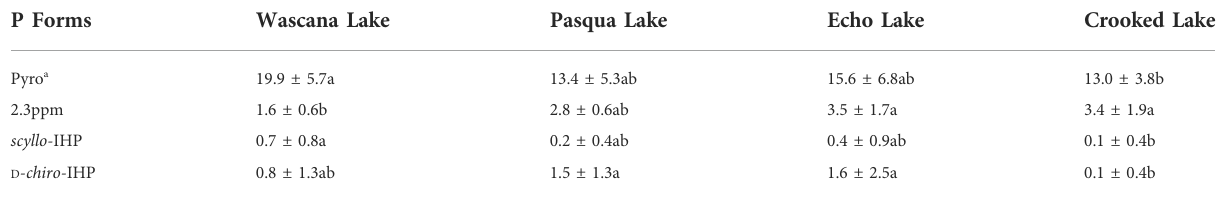
TABLE 3 Concentrations (mgP kg − 1 dryweight) of sediment P species inNaOH-EDTAextracts ofsediments analyzedby P-NMR spectroscopy. Values aremeans(±SD); n =14depths(7depths,duplicatecoresperlake).Differentlettersindicatesigni fi cant( p < 0.05)differencesinconcentrationsof P species among lakes, determined by two-way ANOVAs followed by Tukey HSD post-hoc tests using centred-log ratio data.